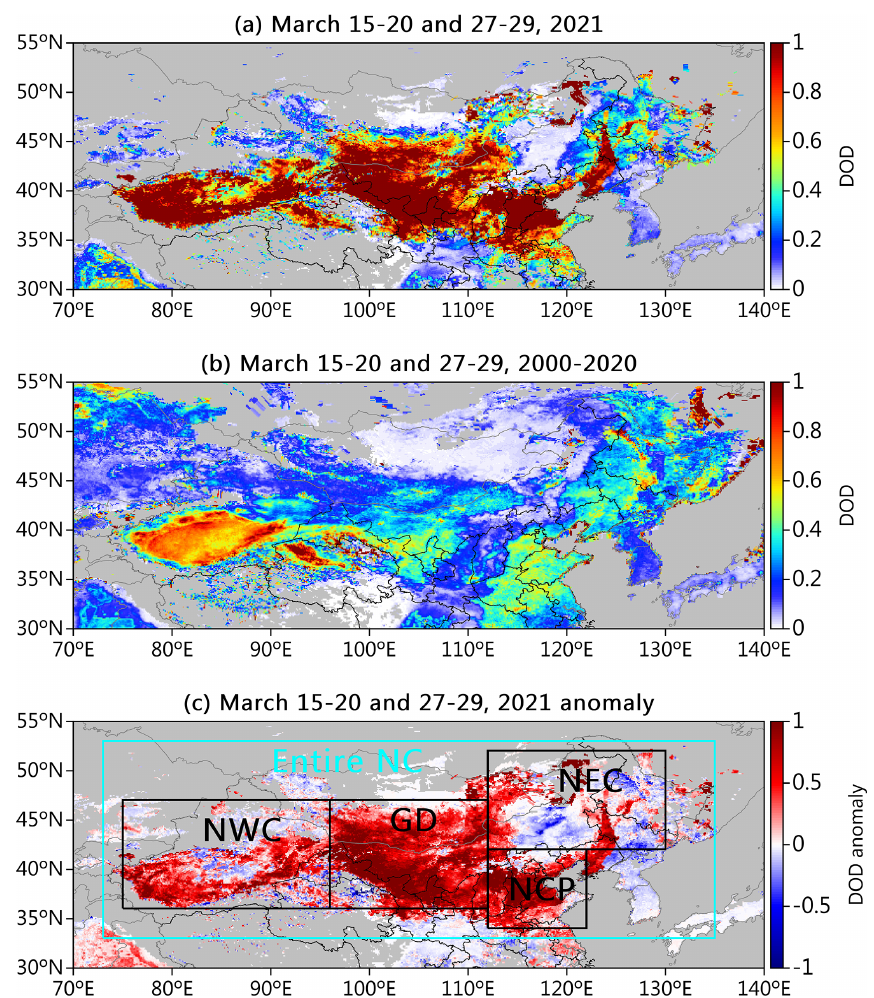
Figure 16. As in Fig. 13 but for the combined MODIS-retrieved DOD from Terra and Aqua during the combined period of 15–20 and 27–29